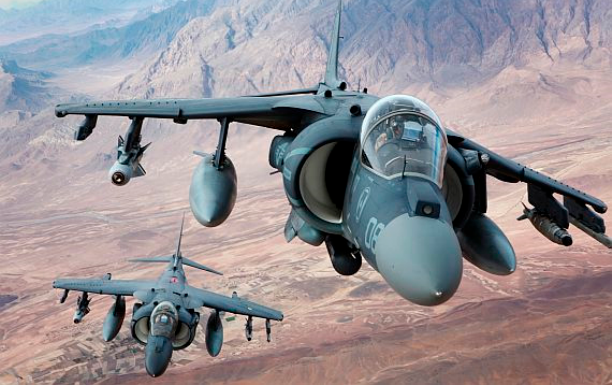
Figure 3. Fiber optic sensing technology applied to fatigue life tracking of AV-8B harrier jet [4].